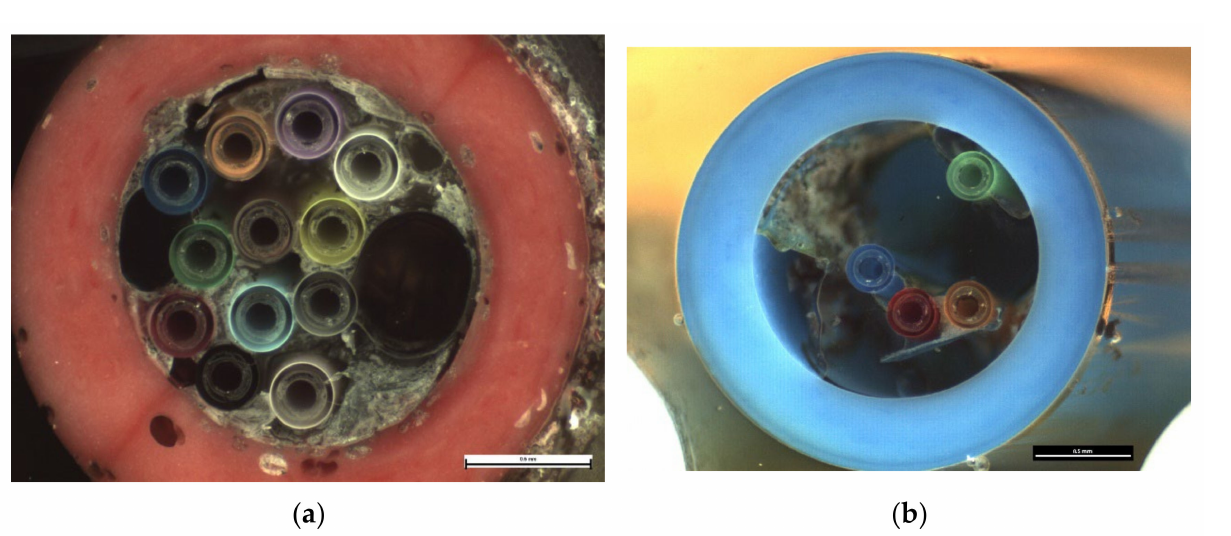
Figure 3. ( a ) Gel-filled loose tube cable: red porous tubes. Tube diameter is 2.3 mm (inserted scale of the picture is 0.5 mm). The same tube was tested with both four fibres as well as 12 fibres running through the cables. ( b ) The non-porous gel-filled tube with four fibres. Tube diameter is 2.2 mm (the scale of the picture is 0.5